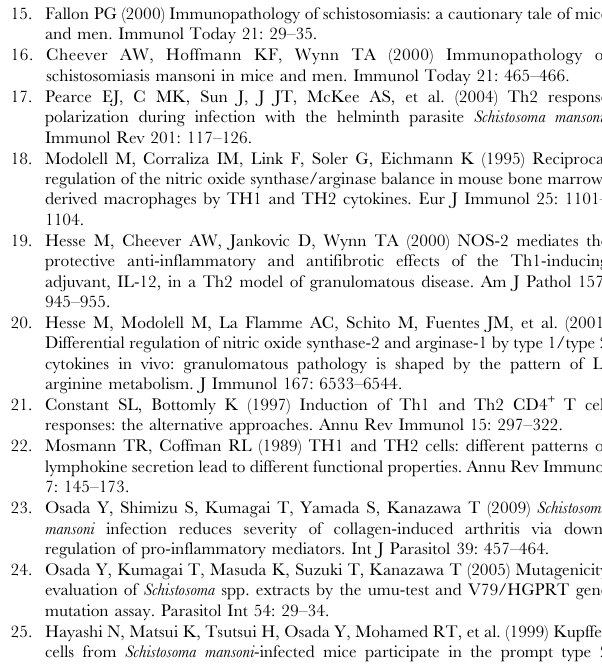
TNF- a , IL-10, IL-5, or IL-17A was analyzed by ICS upon TCR ligation. Insets at the top represent one example using liver lymphocytes prepared at 4 weeks PI. The values represent the percentages in CD4-positive population. This experiment is representative of three independent experiments. Figure S3 S. mansoni infection induced production of IFN- c but neither IL-4 nor IL-13 from hepatic CD8 + T cells. Hepatic lymphocytes were isolated from S. mansoni -infected mice at 6 weeks PI, and ICS was conducted for investigating the potential of CD8 + T cells to produce IFN- c , IL-4, or IL-13. One example representative result is shown. The percentages in the insets represent the proportions in CD8-positive population. Similar results were obtained in five independent experiments. (TIF) Figure S4 Neither c 13 nor c 4 cells were induced in the spleens of S. mansoni -infected mice. (A and B) Hepatic lymphocytes and splenocytes were isolated from S. mansoni -infected mice at indicated time points, and ICS was conducted after TCR stimulation. (A) One example using hepatic lymphocytes prepared at 6 weeks PI is displayed. The percentages in the insets represent the proportions in CD4-positive population. (B) The proportions of c 4 cells (upper graph) or c 13 cells (lower graph) in CD4-positive hepatic or splenic lymphocytes were investigated. Similar results were obtained in three independent experiments. Figure S5 The unique T cells were induced in the livers of S. mansoni -infected C57BL/6 mice. (A and B) Hepatic lymphocytes were isolated from S. mansoni -infected BALB/c or C57BL/6 mice at indicated time points, and ICS was conducted upon TCR ligation. (A) One example using liver lymphocytes prepared at 6 weeks PI is exhibited. (B) The proportions of c 4 cells (upper graph) or c 13 cells (lower graph) in CD4-positive hepatic